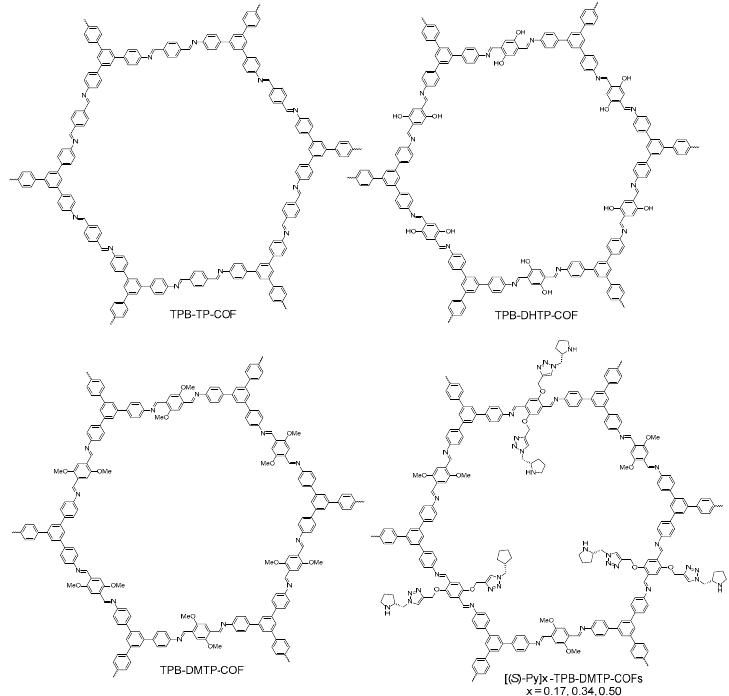
Figure 14. Synthesis and structure of stable crystalline porous COFs through softened interlayer charge repulsion. ( a ) TPB-TP COF control; ( b ) TPB-DHTP COF control; ( c ) stable crystalline porous COF of TPB-DMTP COF; ( d ) functionalization of TPB-DMTP COF ([( S )-Py] x -TPB-DMTP-COFs, x = 0.17, 0.34, 0.50).